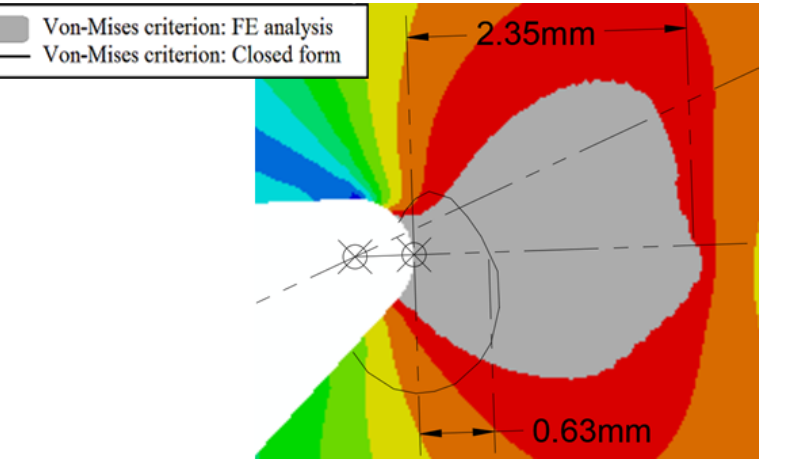
Figure 11. EPZSs obtained from FE analyses and the proposed methodology (closed-form solution). Notch radius and notch rotation angle were 0.5 mm and 25°, respectively. σ 0 was used instead of σ Y in the analytical solution.